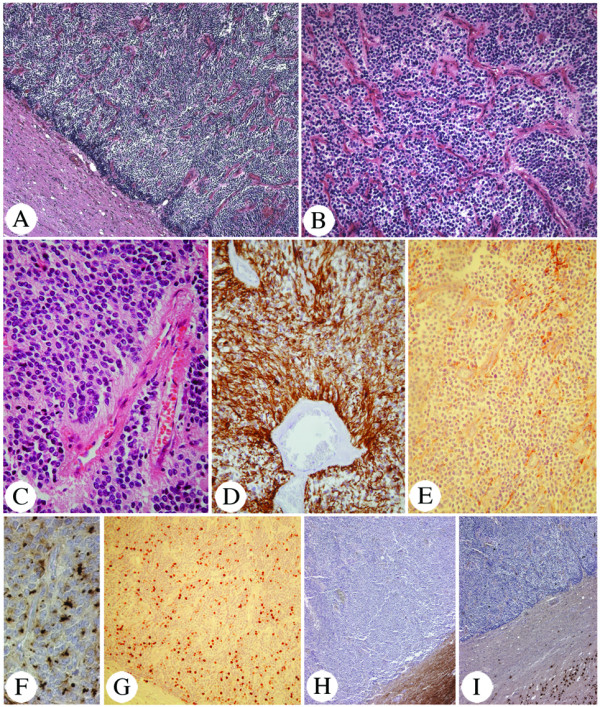
Histological characteristics of trisomy 19 ependymoma: compactness with clear cut border (A, HE, 30×); rich branched capillary network (B, HE, 90×); perivascular pseudorosettes, always observed, but can be rare (C, HE, 250×); GFAP positivity, always observed (D, GFAP, 125×) but can be focal with large GFAP negative area (E, GFAP, 125×); focal region of tumoral cells with intra-cytoplasmic EMA dots, always found (F, EMA, 310×); Ki67 >10% (G, Ki67, 60×); neuronal markers: negative in the tumor, positive in the surrounding brain parenchyma (H: NF, 30× and I: Neu-N, 30×).